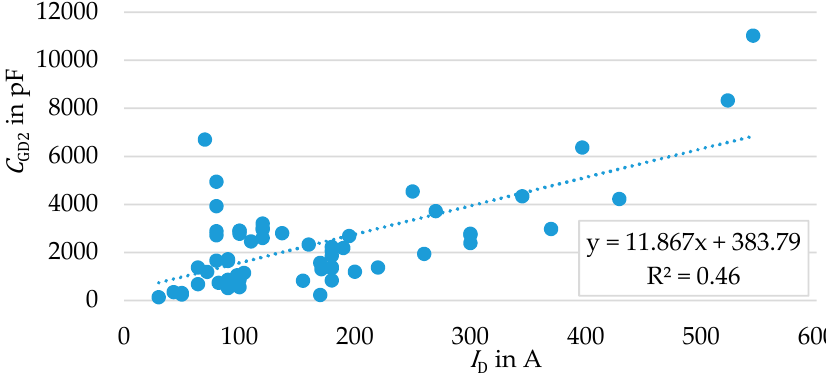
Energies 2019 , 12 , x FOR PEER REVIEW Figure 6. Relation between the current I D and the capacitance C GD2 .